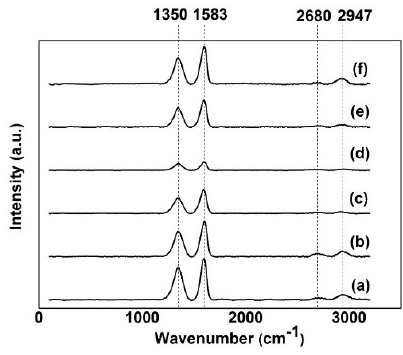
Figure 8. Raman spectra of ( a ) GO; GO electrochemically reduced at ( b ) 5 V, ( c ) 10 V, ( d ) 15 V, ( e ) 20 V, and ( f ) 25 V.